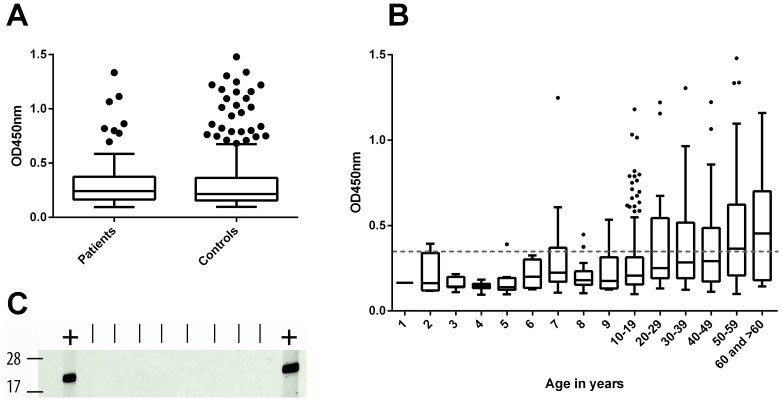
Anti-M. ulcerans 18 kDa shsp IgG titres in sera from Ghanaian BU patients and control individuals.
A Box plots showing OD values of 1∶100 diluted sera from Ghanaian BU patients (n = 96) and control individuals (n = 384) tested in an anti-M. ulcerans 18 kDa shsp IgG specific ELISA. B Boxplot showing the distribution of OD values for BU patients and control individuals for different age groups. No IgG titres above the background level were observed for children below the age of 5 years. The background response (OD<0.35) is indicated as a dotted line. C Sera from eight 2-year-old children were tested by Western Blot analysis to reconfirm the absence of anti-M. ulcerans 18 kDa shsp IgG. An ELISA positive control serum (OD = 0.76) was included (+) flanking the tested sera.